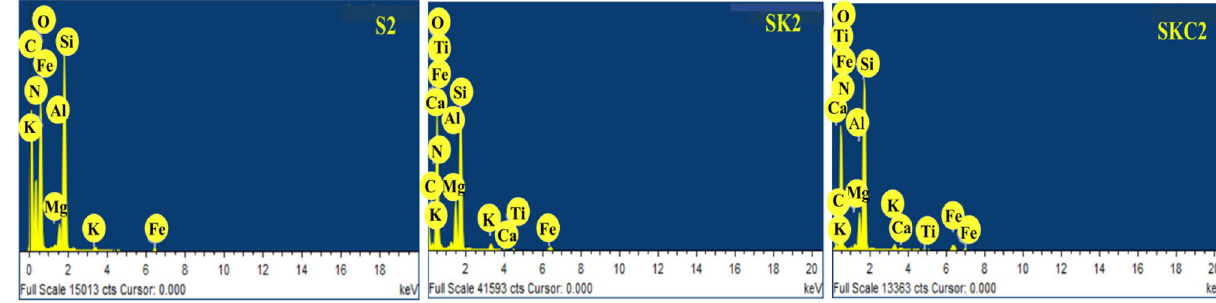
Fig. 3 EDS spectra of the samples S2, SK2, and SKC2 Table 2 Elemental compositions (at. %) of the samples S2, SK2, and SKC2, respectively